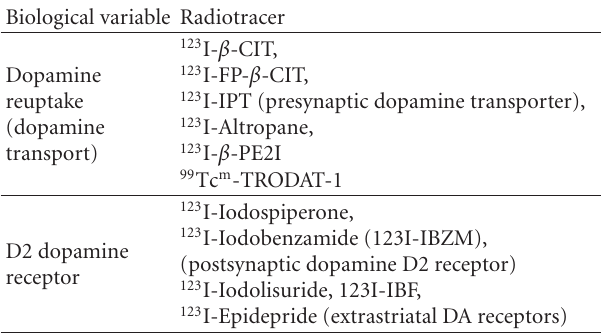
Table 1: The tracer used for SPECT in Parkinson’s